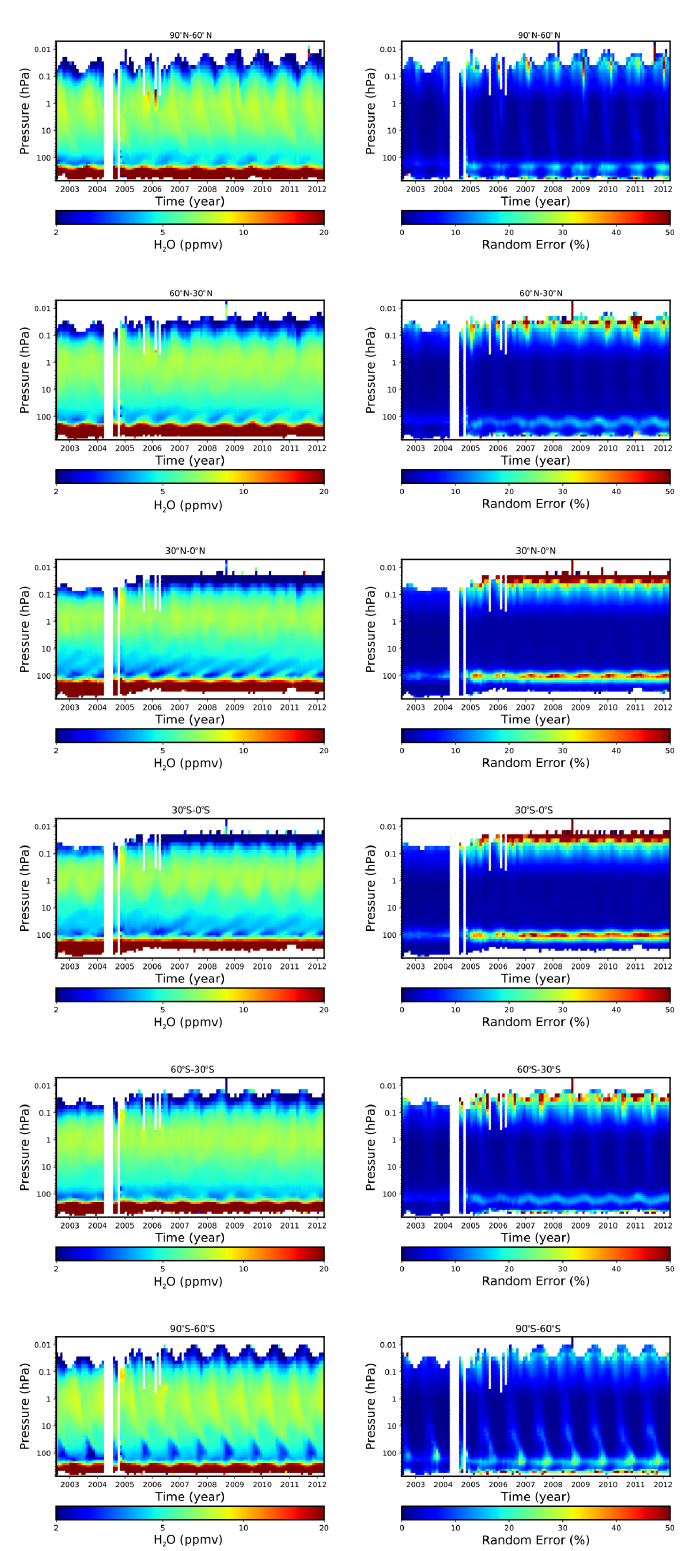
Figure 11. Time series of the monthly means of the water vapour profiles (left panels) and their random errors (right panels) as a function of pressure for the same latitude bands of Fig. 9. From top to bottom: polar north, midlatitude north, equatorial north, equatorial south, midlatitude south, and polar